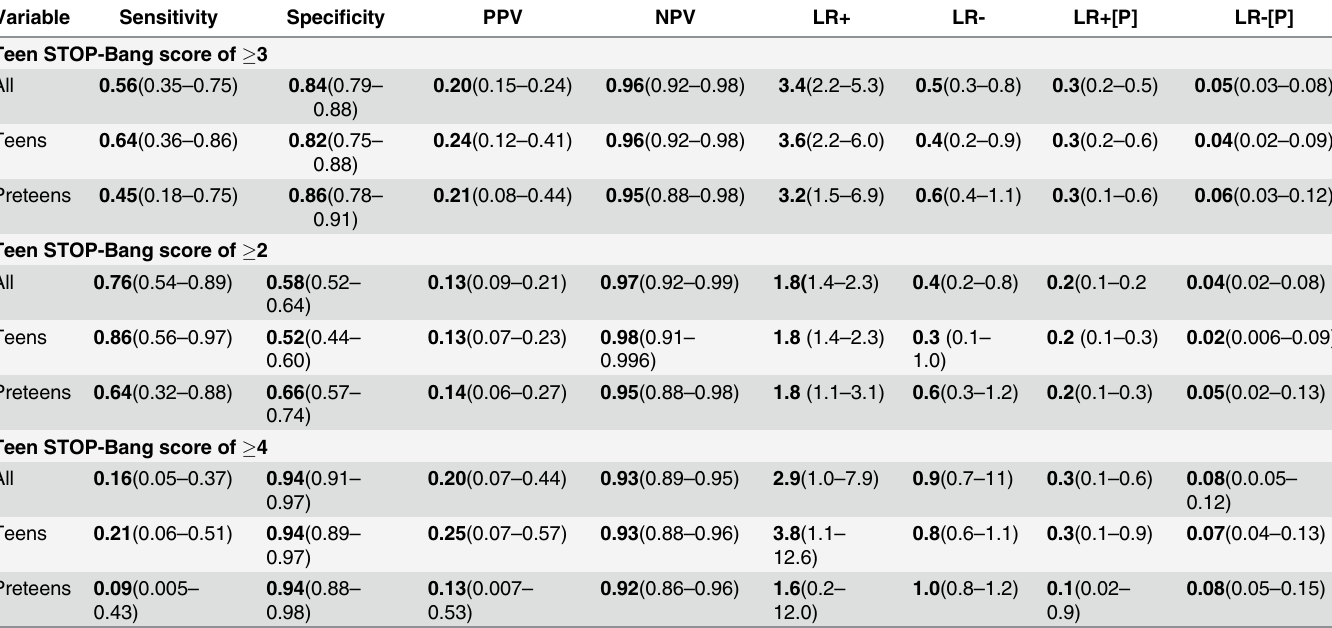
Table 2. Test Characteristics of teen STOP-Bang Scores with sensitivity analysis for various thresholds.